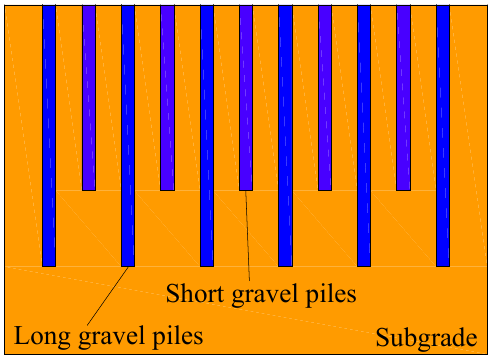
Figure 2. Interphase long-short gravel piles.